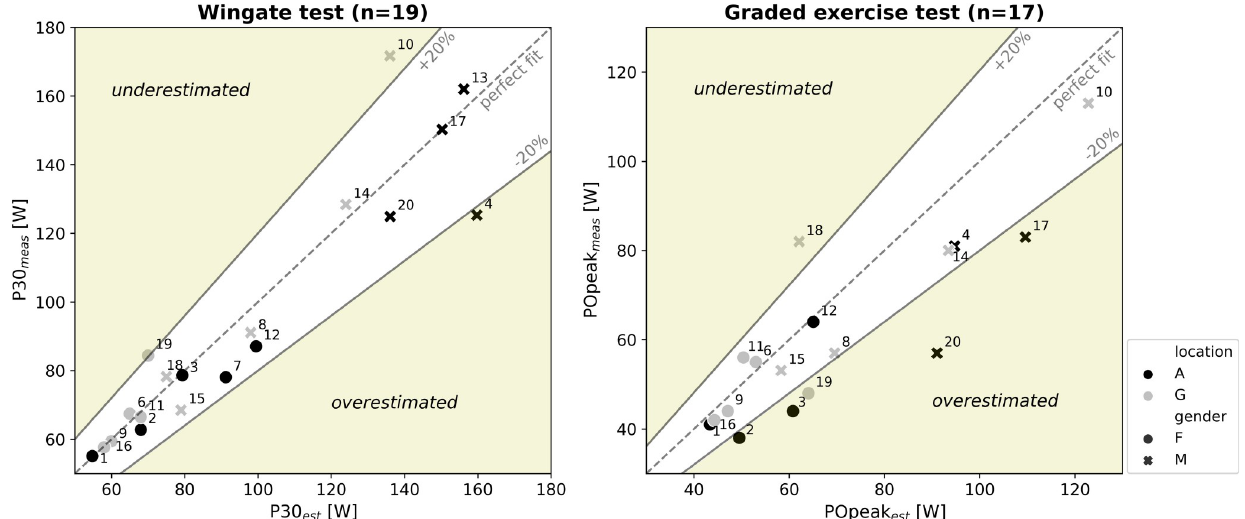
Fig 4. Comparison of the individual estimated P30 (left graph) and POpeak (right graph) with the actual measured P30 and POpeak. The number attached to the symbol is the same as participant numbers in Table 1. Dotted lines correspond w a perfect fit and solid lines represent 20% boundaries. A = measured in Amsterdam, G = measured in Groningen, F = female, M = male.